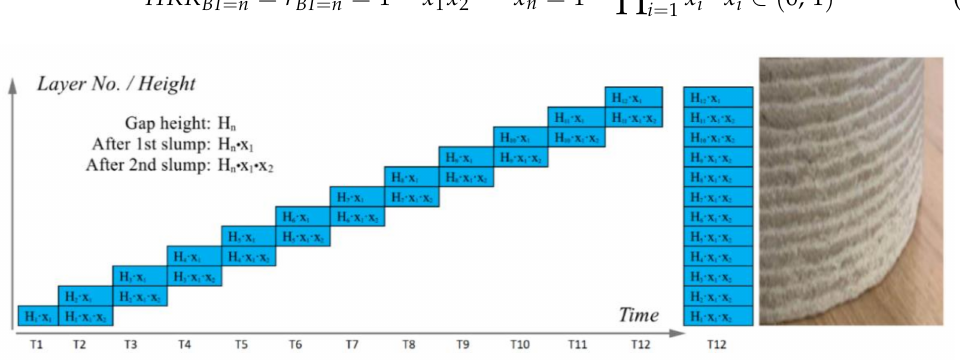
Figure 15. Printing process with a two-step slump